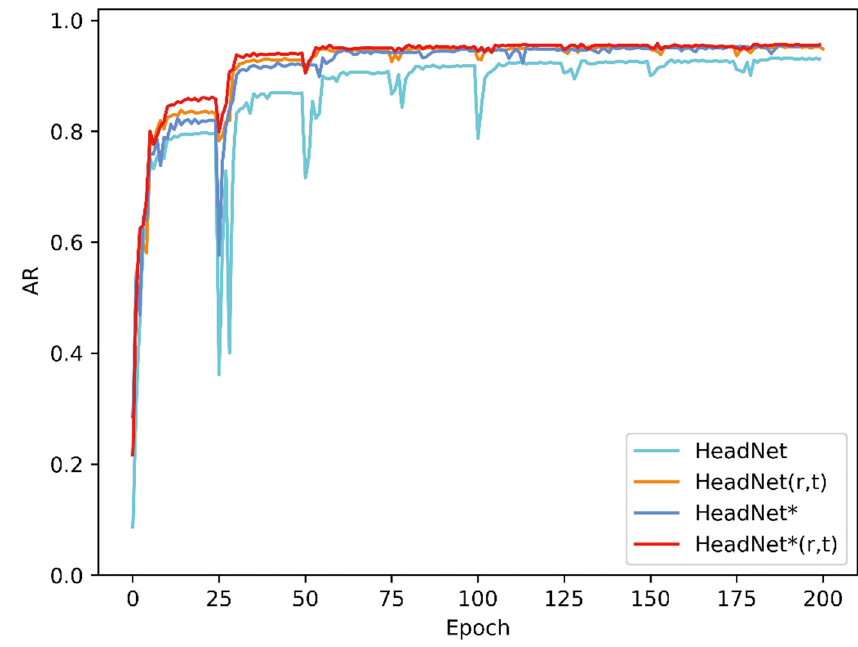
Figure 7. Changes in validation AR of HeadNet.